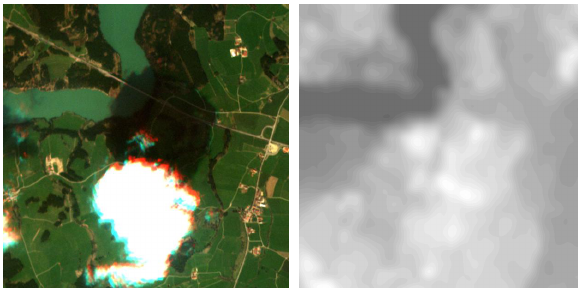
Figure 8: Example of a cloud in the RapidEye image near Schon- gau, section 3 . 1 × 3 . 1 km, left RapidEye image, right ellipsoid DEM ranging from 745 to 845 m